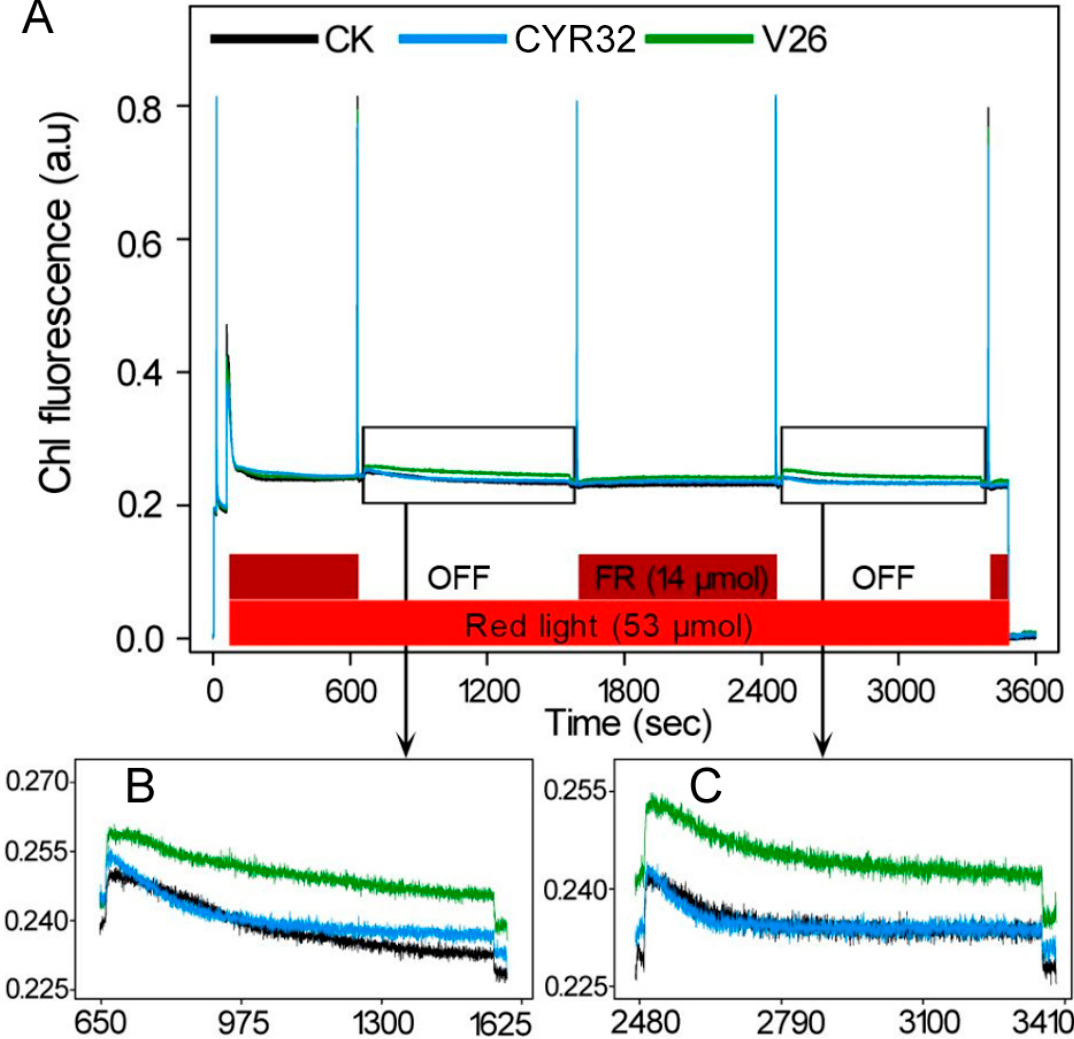
Figure 8. Assays of state transitions in wheat cultivar CM42 inoculated with CYR32 and V26 at 120 hpi. ( A ) Pulse amplitude-modulated fluorescence traces after shifts from state 1 to state 2 light and back. ( B , C ) Enlargement of a section of ( A ). Fluorescence response curves when illumination of light is changed back to favor PSII (state 1 to state 2 transition). The bars at the bottom show illumination with red (shown in red) and far-red (dark red) light. Fluorescence is shown in arbitrary units.